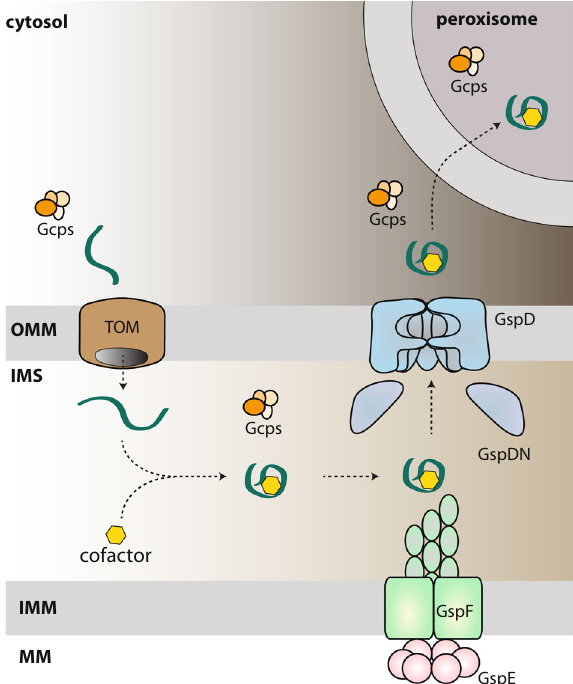
Fig. 9 The mitochondrial T2SS (miT2SS) as part of a hypothetical eukaryotic functional pathway connecting the mitochondrion and the peroxisome. The scheme presents the most reasonable interpretation of the fi ndings reported in this study, but further work is needed to test details of the working model. According to the model, a nucleus-encoded protein (green), possibly one of the newly identi fi ed Gcp proteins, is imported via the TOM complex into the mitochondrial inner membrane space, where it is modi fi ed by addition of a speci fi c prosthetic group. After folding it becomes a substrate of the miT2SS machinery, is exported from the mitochondrion and fi nally reaches the peroxisome. The loading of the prosthetic group, the delivery to the peroxisome and possibly also the actual function of the protein in the peroxisome is assisted by speci fi c subsets of other Gcp proteins. The hypothetical presence of Gcp proteins in speci fi c (sub)compartments is depicted as a group of orange ovals. OMM outer mitochondrial membrane, IMS intermembrane space, IMM inner mitochondrial membrane, MM mitochondrial